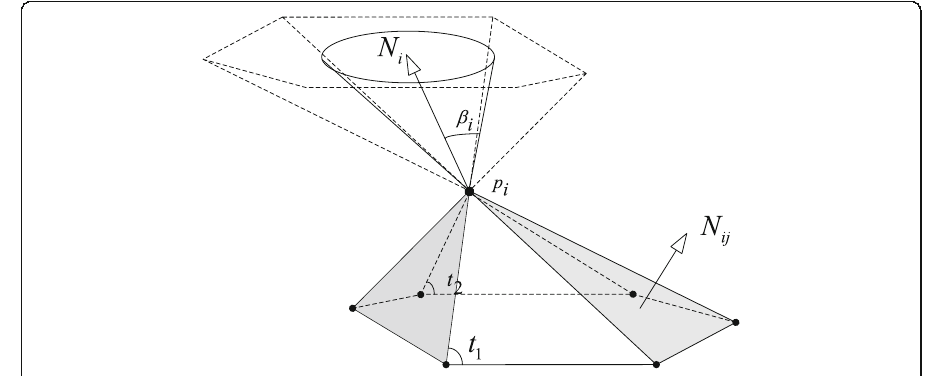
Fig. 2 The visibility region and its subset (a cone region) at a front